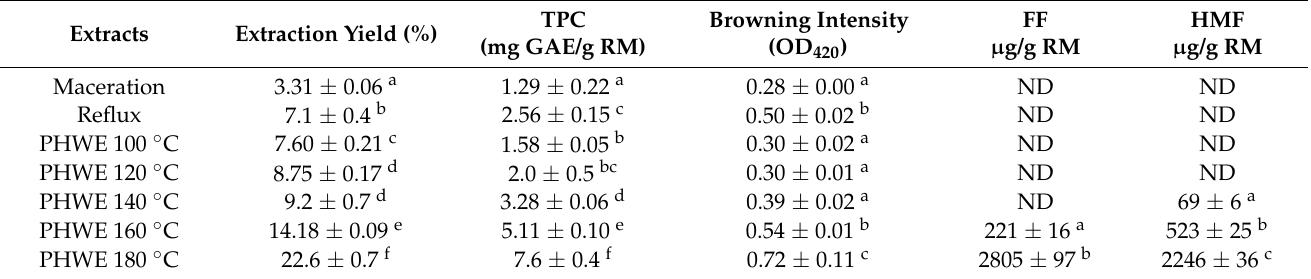
Table 1. Comparisons between the extraction yield, TPC, OD 420 value, and contents of FF and HMF in the extracts obtained from PHWE at different temperatures and from conventional